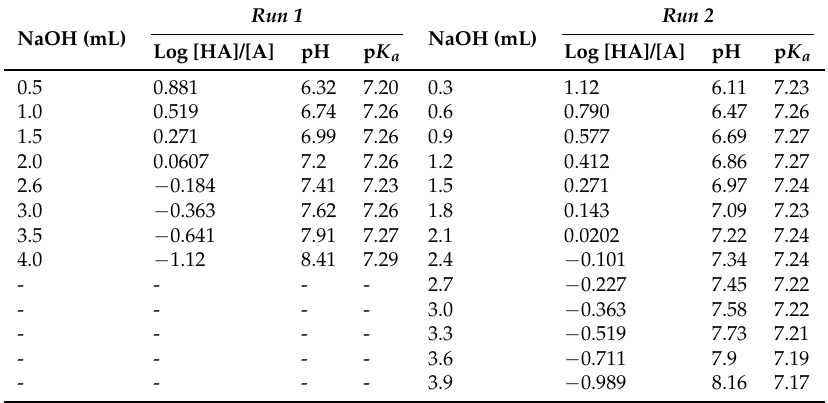
Table 7. Calculations of the acidity constants of 3 (Table 1), according to the results of two titrations. p K a = 7.25 and 7.23 as the arithmetic mean of all 8 values in the set Run 1 and of 13 values in set Run 2 ,